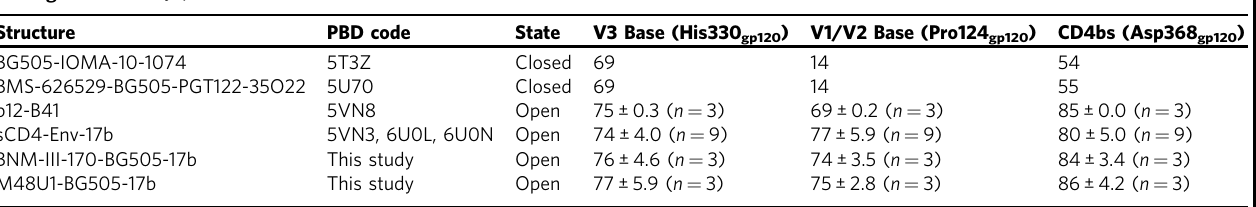
*For asymmetrically open structures, distances shown are mean±s.d. of n number of